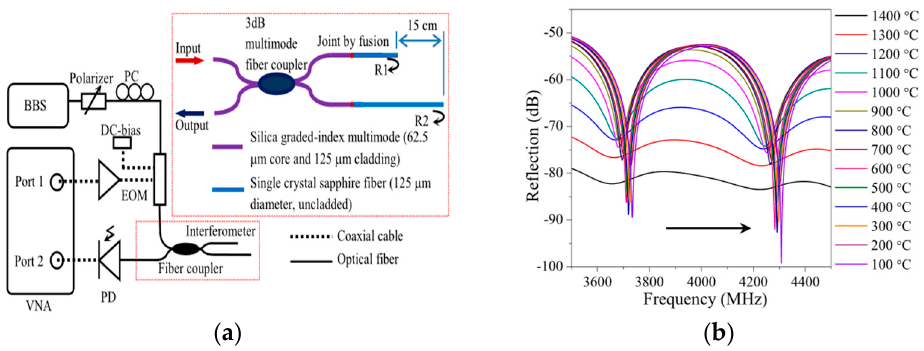
Figure 11. ( a ) Schematic of an OCMI interrogation system; ( b ) Interference fringes of the SP fiber- based OCMI at different temperatures ranging from 100 ◦ C to 1400 ◦ C. (Reprinted with permission from Ref.